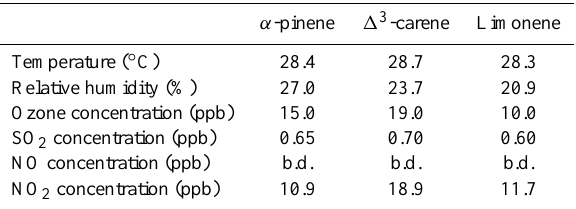
Table 2. Conditions at the start of events in the Set 1 experiments The values below the detection limit are denoted by